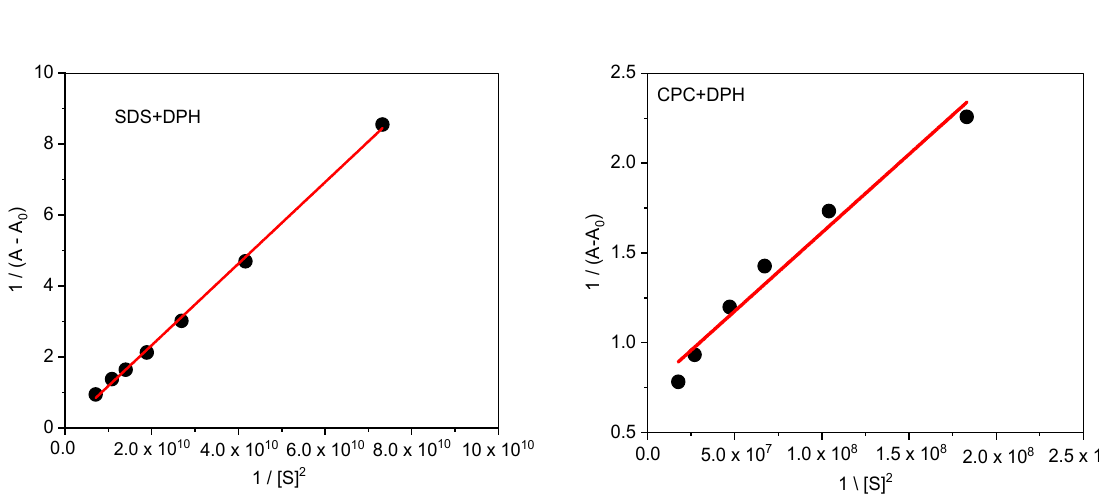
Figure 5. The plot of 1/(A–A 0 ) vs. 1/[S] 2 for the interaction of DPH with SDS and CPC in an aqueous solution. The values of free energy change are − 48.63 and − 45.249 kJ · mol − 1 for DPH+SDS and DPH+CPC, respectively. The values of ∆ G K were found to be negative to confirm the spontaneity of the process of